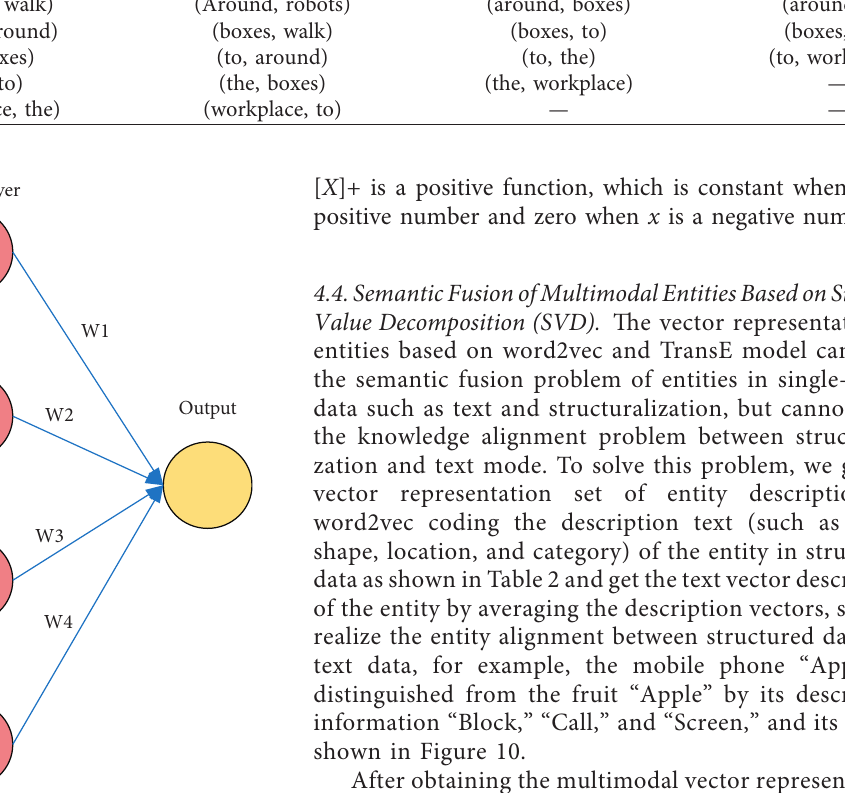
Figure 7: Neural network model.